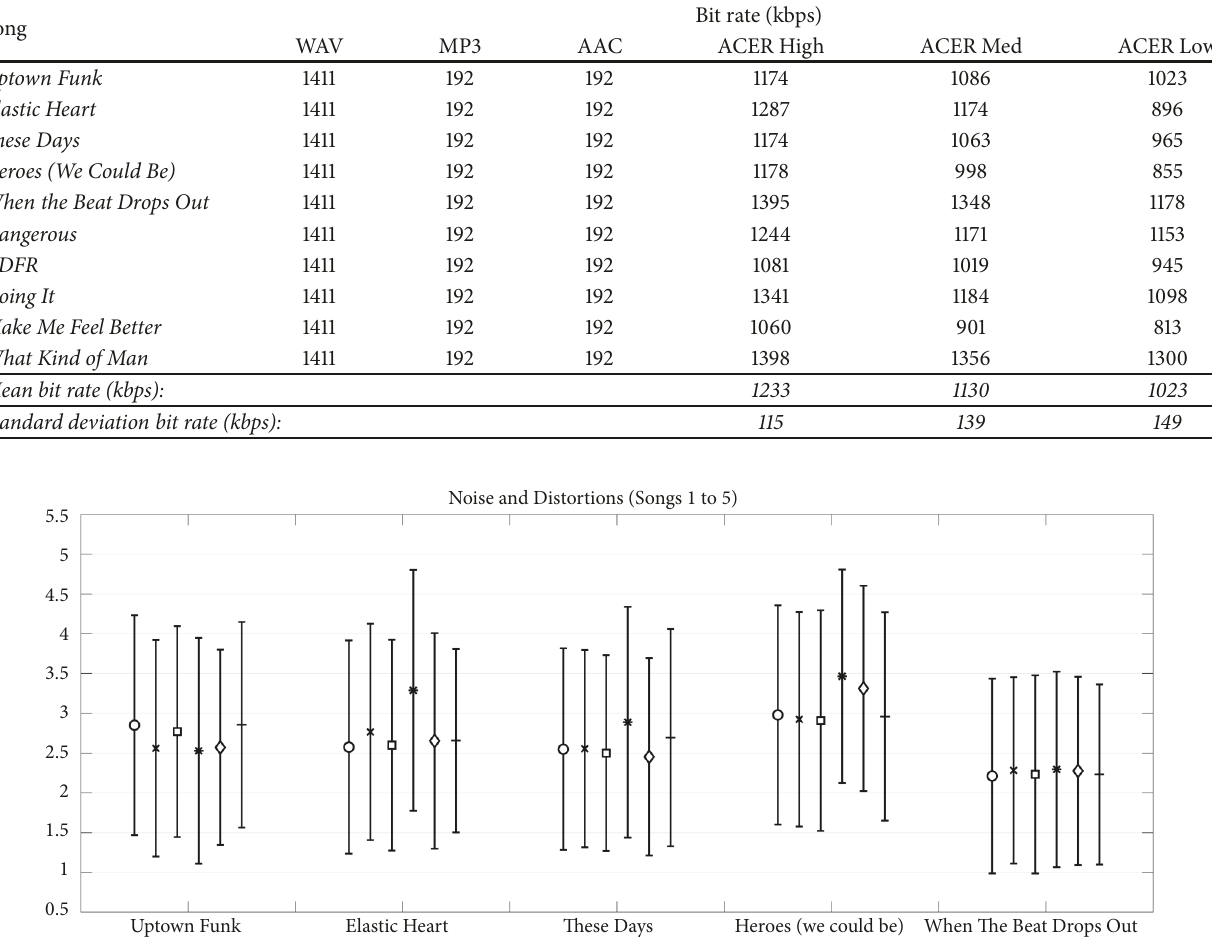
Figure 2: Noise and distortions results (songs 1 to 5). A score of 1 represents imperceptible noise and distortions and a score of 5 represents perceptible noise and distortions.